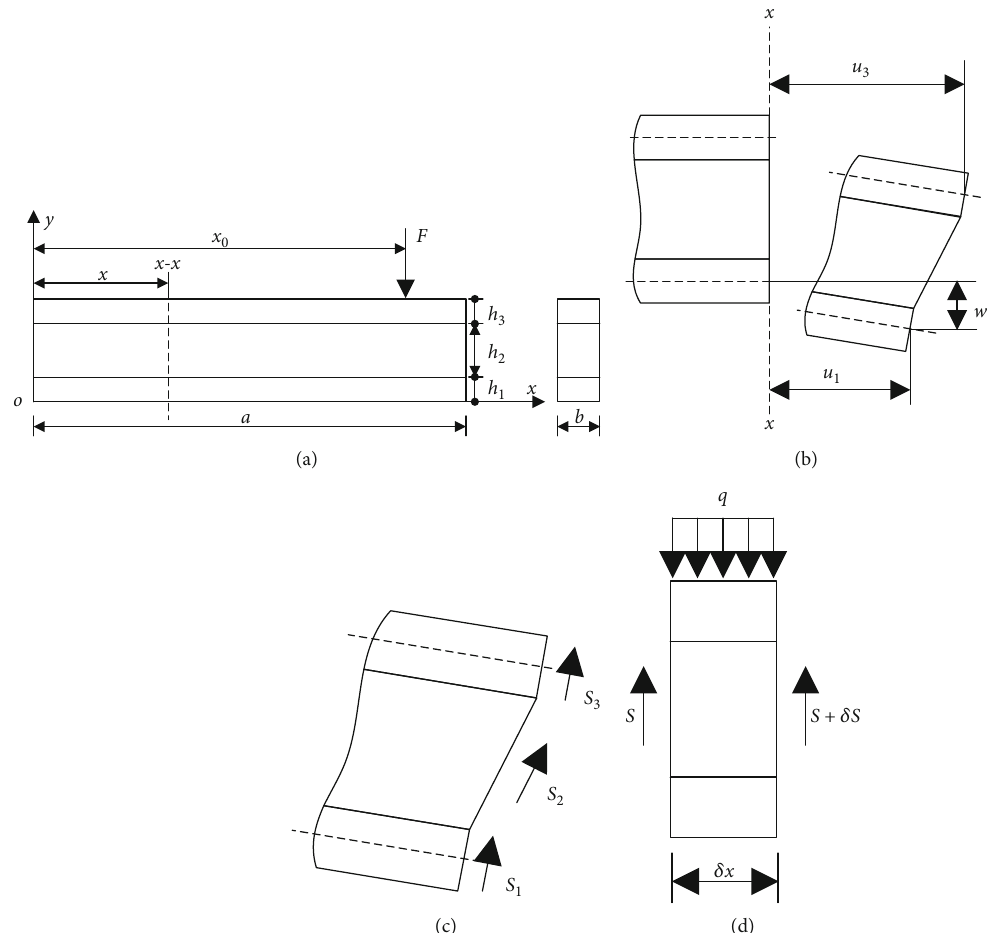
Figure 1: The schematic diagram of (a) cantilever sandwich beam, (b) x - x section, (c) deformed x - x section, and (d) the shear force of the